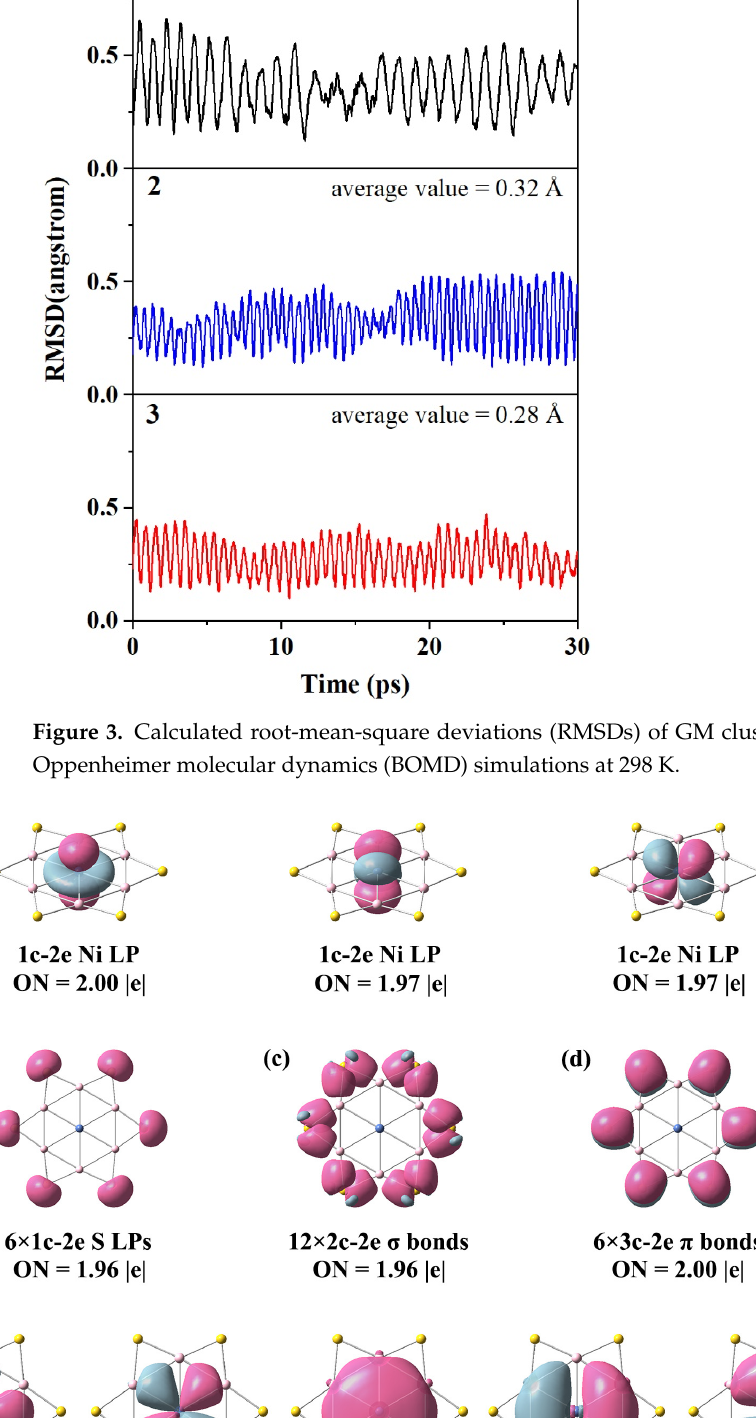
Table 1. The lowest vibrational frequencies ( ν min /cm − 1 ), HOMO-LUMO gaps (Gap/eV), Wiberg bond indices, and atomic nature charges (q, |e|) of MAl 6 S 6 (M = Ni, Pd, Pt) at the PBE0/def2-TZVP level. Species